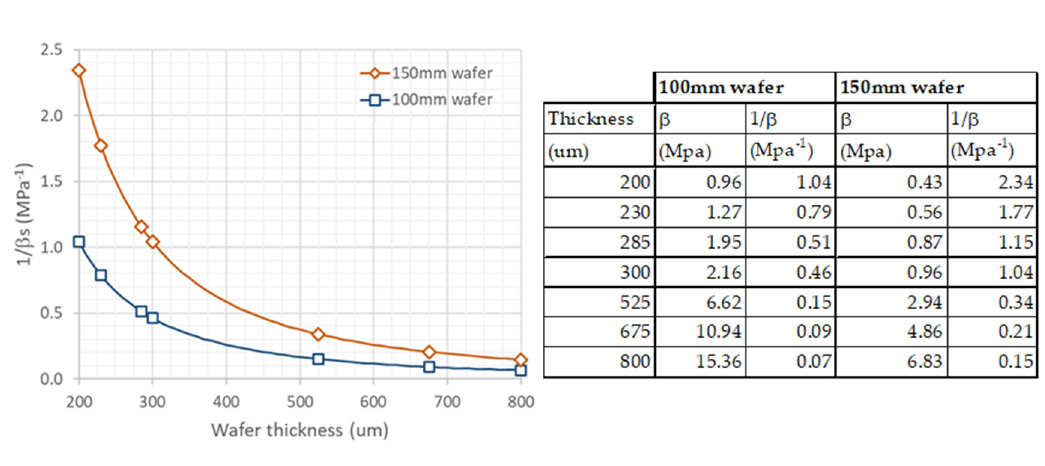
Figure 4. Variation of substrate parameter 1/ β s with wafer thickness (left) and values of β s for typical wafer thicknesses for 100 mm and 150 mm diameters. Table 1. Coefficient of thermal expansion and biaxial elastic module G of various materials used in 3D technology.